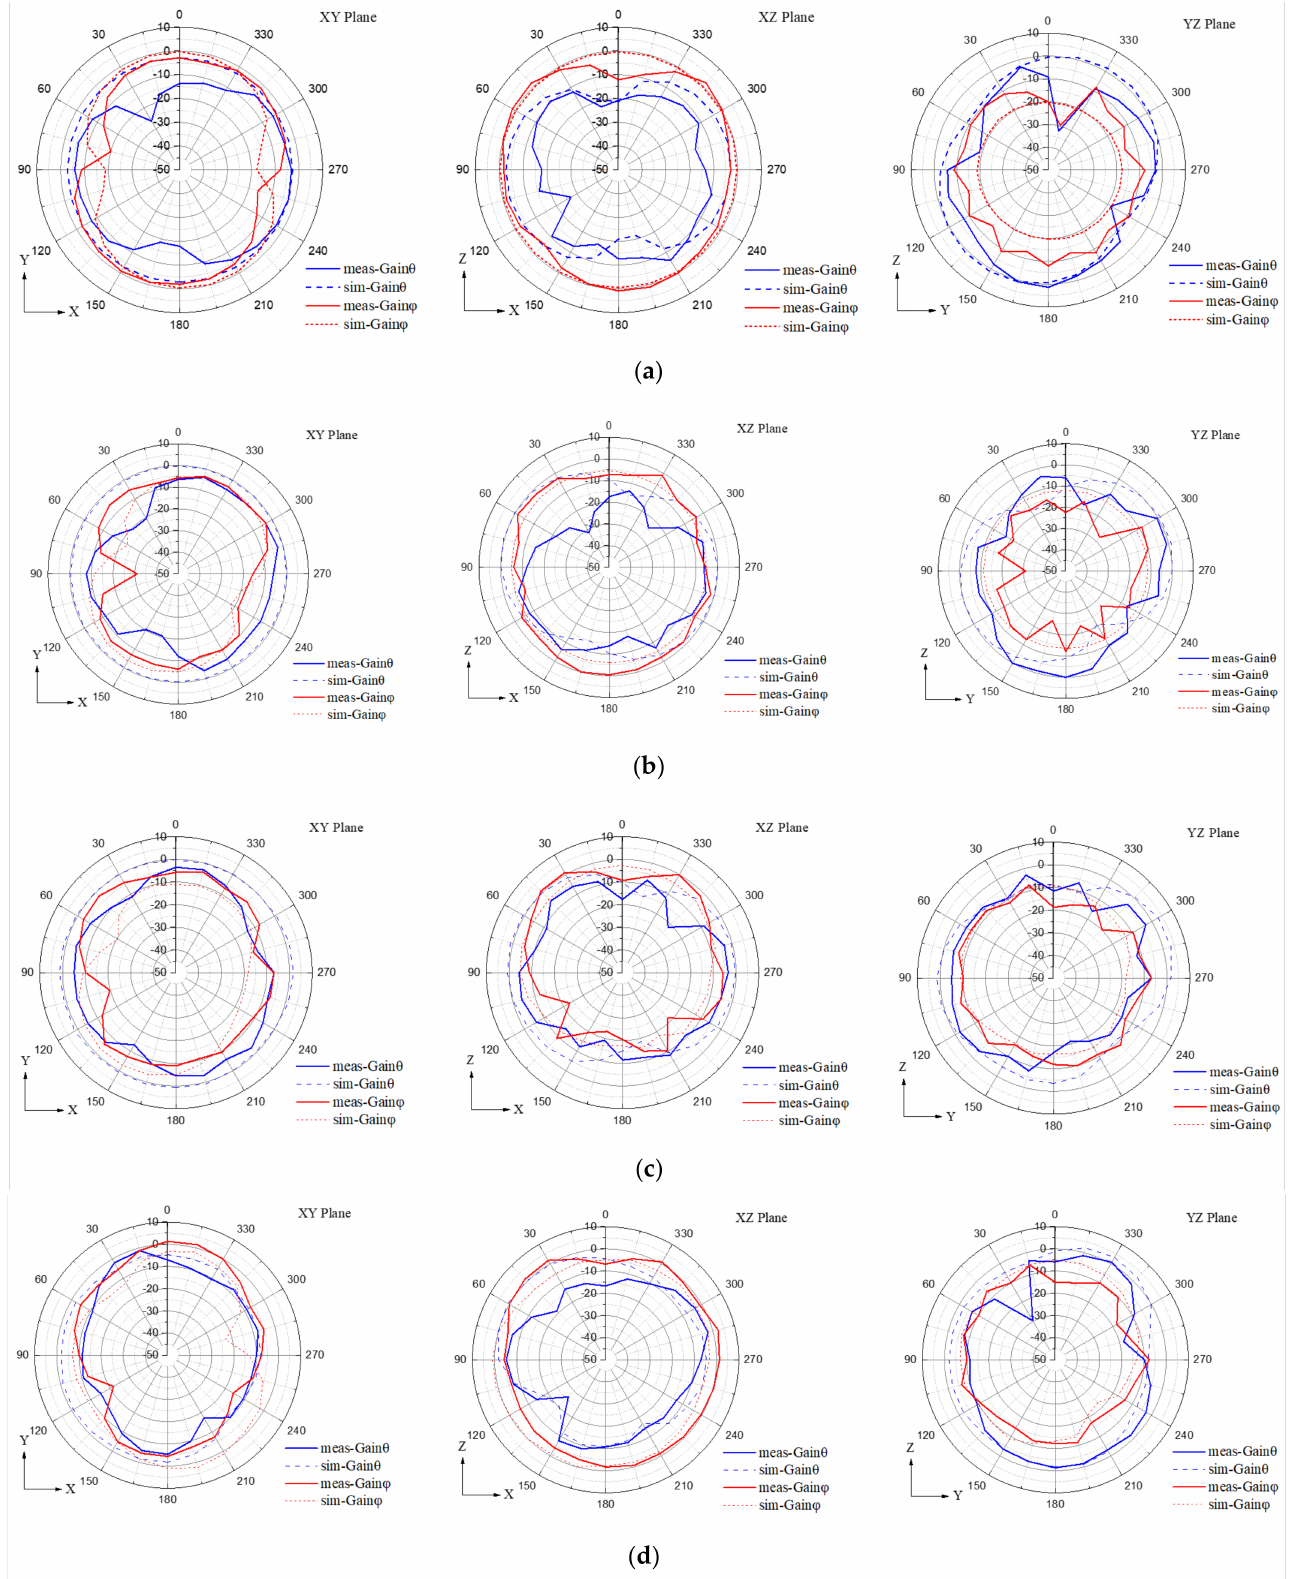
Figure 22. 2D gain simulation and measurement comparison results for Ant. 3. ( a ) 2.45 GHz; ( b ) 3.5 GHz; ( c ) 5.5 GHz; ( d ) 6.8